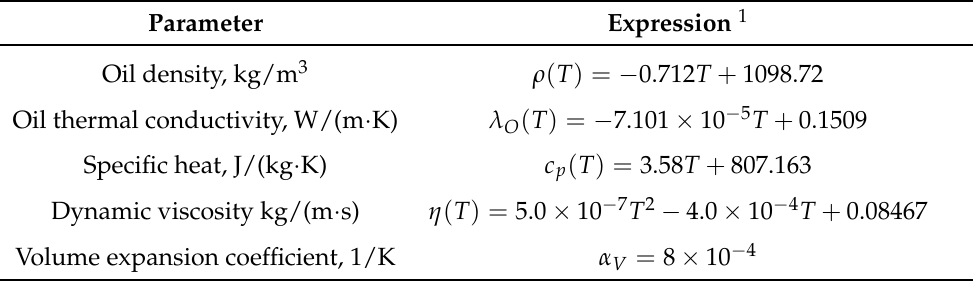
Table 1. Physical parameters of Karamay 25 # transformer oil.